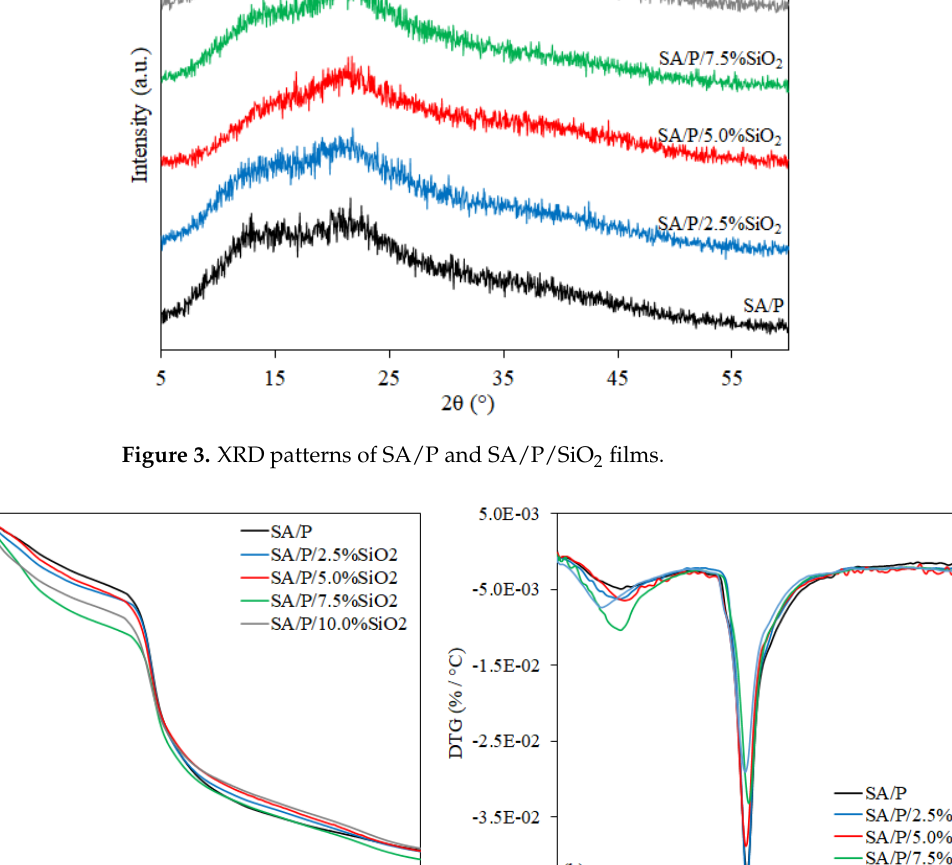
Figure 3. XRD patterns of SA/P and SA/P/SiO 2 films.